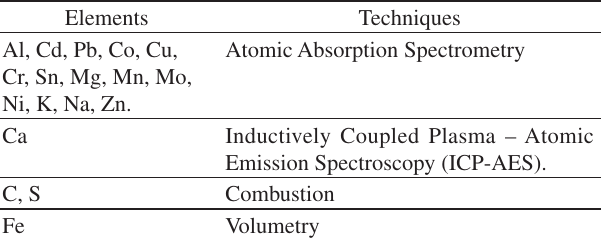
Figure 1. Methodolo�y �sed �or the EAFD samples di�estio�. Table 1. Tech�iq�es �sed i� the sample 1 eleme�tary chemical a�alysis.